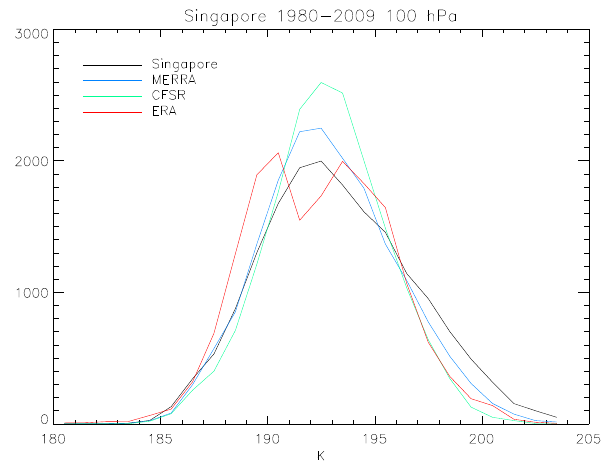
Fig. 1b. Winter temperatures and saturation water vapor concentra- tion using Murphy and Koop (2005) for observations from Singa- pore and the three reanalyses at Singapore. Solid lines, mean tem- peratures from 1979–2010; dashed lines, one standard deviation be- low the mean. MLS (2005–2010) is zonal average of 100hPa ob- servations for the months of